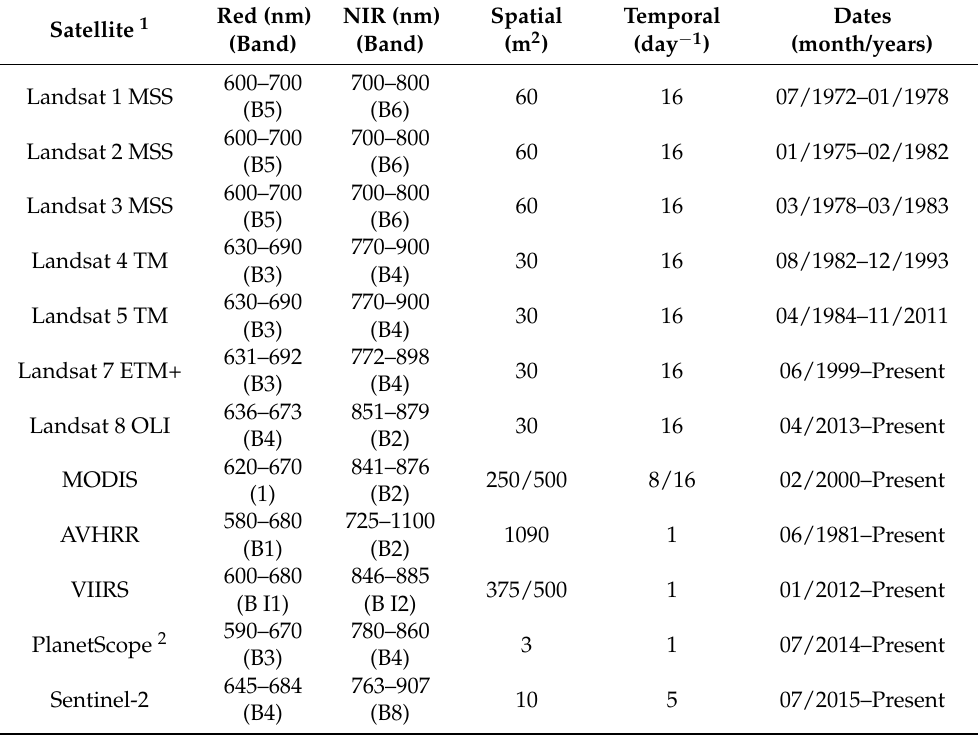
Figure 1. EOS platform data on Google Earth Engine. Dates of availability (years), temporal resolution (days per month), red and near infrared spectral bands λ in nanometers (nm) used for NDVI, and spatial resolution in meters (m). Table 1. Available Earth Observation Systems (EOS) platform radiometric bands (in nanometers (nm)) used to calculate Normalized Difference Vegetation Index (NDVI), spatial resolution (meters (m 2 )), and temporal resolution repeat [days], and dates of